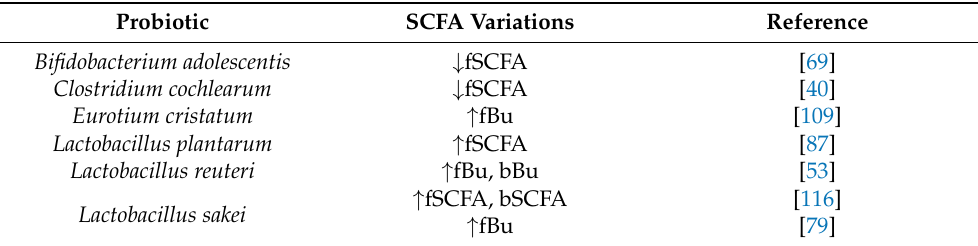
Table 3. Effects of probiotics on HFD-fed mice and